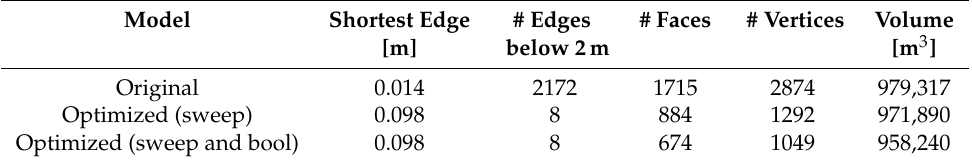
Table 1. Optimization overview. The sweep algorithms increases the smallest edge and substantially reduces the number of small edges. Additional Boolean operations further decrease the number of faces and